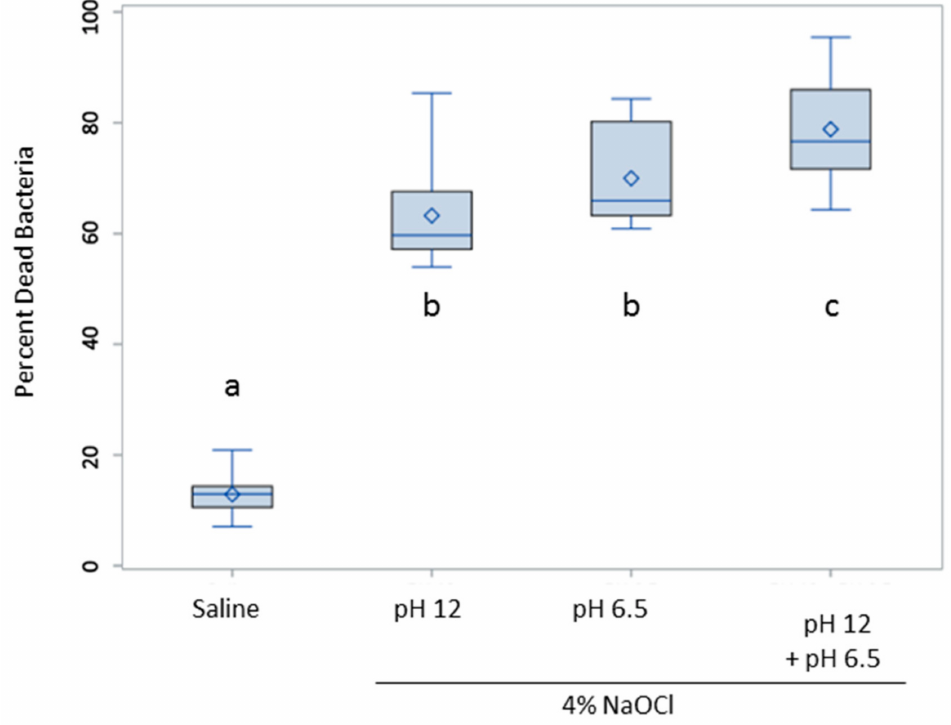
Figure 1. Mean and range (box plots) of the percent of red cells (dead cells) after 4 min of contact with the solutions. The bactericidal e ff ect of the irrigants on E. faecalis biofilms is expressed as the ratio of red cells to green and red cells, indicating the proportion of dead cells in the biofilm. The percent of dead cells in the 0.9% saline solution group was significantly lower than those in the other groups ( p < 0.0001). There was no significant di ff erence in the percent of dead cells between 4% NaOCl pH 12 compared to acidified 4% NaOCl pH 6.5 ( p = 0.0802). The sequential use of 4% NaOCl pH 12 followed by 4% NaOCl pH 6.5 significantly increased the percent of dead cells compared to both the samples exposed to either 4% NaOCl pH 12 or 4% NaOCl pH 6.5 ( p < 0.0008 and p < 0.0276, respectively). Similar low case letters indicate no di ff erence; di ff erent letters indicate significant di ff erence between the groups. The box represents the interquartile range (IQR) and extends from Q1 to Q3. The rhombus indicates the mean and the horizontal bar indicates the median. Upper and lower “wiskers” indicate the maximum and minimum